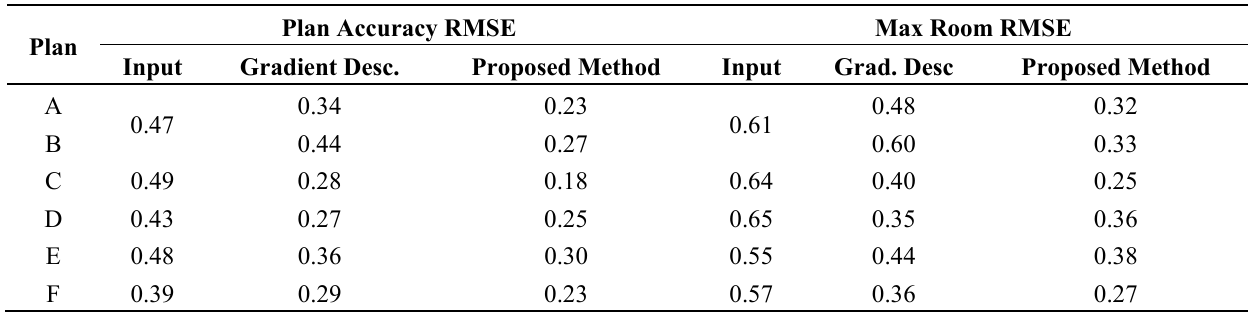
Table 1. RMSE (m) by plan vs. ground